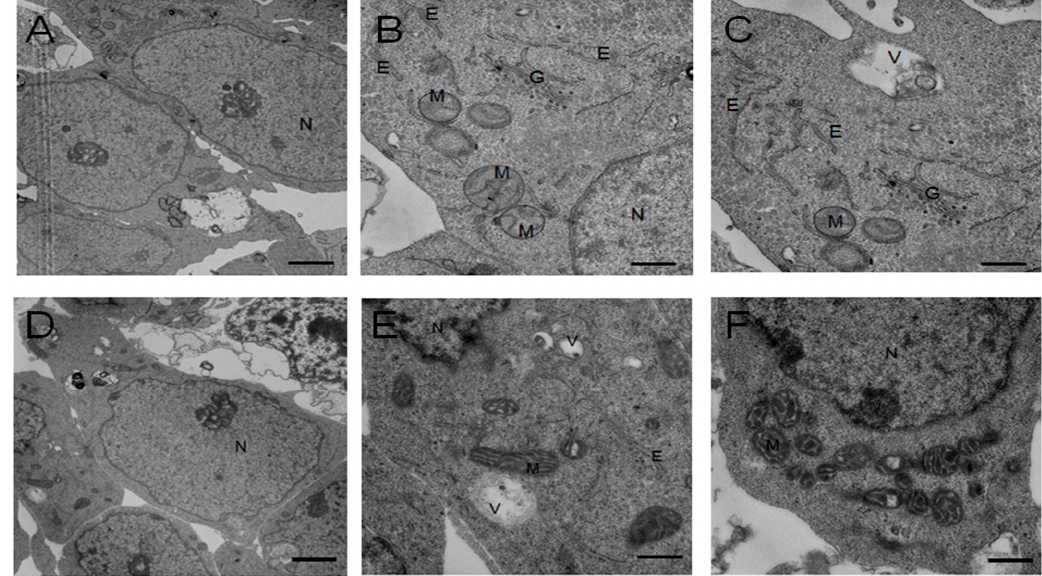
Figure 8. Transmission electron microscopy analysis of H9 hESCs p57 after ten passages cultured in homemade E8 medium containing hFGF-2 ( A – C ) or hDJ-1 ( D – F ). Scale bar indicates 2 µm ( A , D ) and 500 nm ( B , C , E , F ). N: nucleus, M: mito-